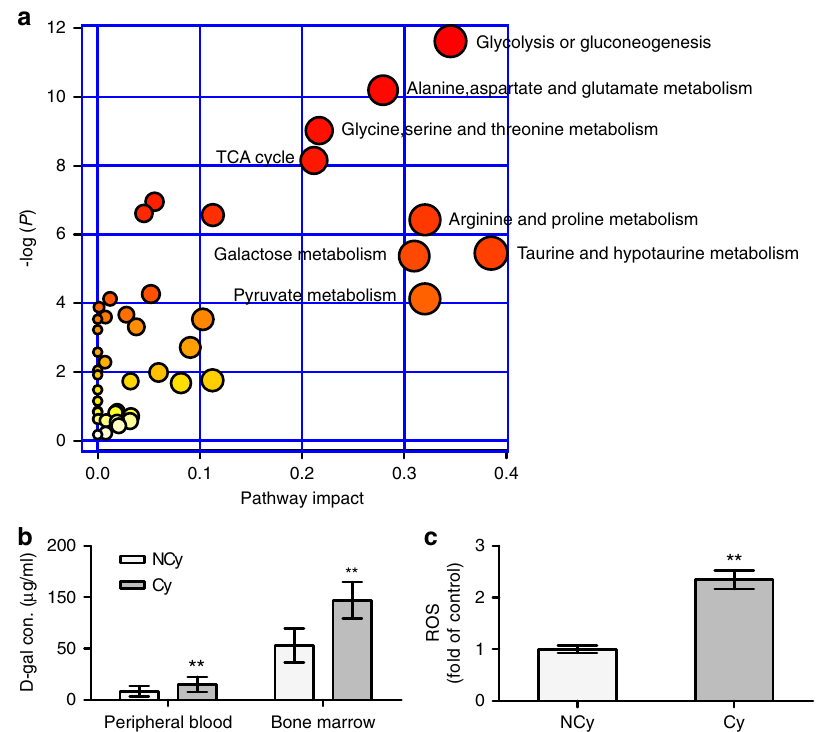
Fig. 2 Profound hypoxia altered metabolic pro fi ling in BM. a Pathway analysis of 49 metabolites identi fi ed as being present in the Cy group but not in the NCy group. x Axis represents the pathway impact, and y axis represents the pathway enrichment. Larger sizes and darker colours represent increased pathway enrichment and higher pathway impact values, respectively. b D -galactose concentrations in the peripheral blood ( n = 22 per group) and bone marrow ( n = 5 per group) of patients were analysed. c ROS levels of BMSCs from the NCy and Cy groups were analysed. The data shown are the mean ± SD from three independent experiments, and statistical signi fi cance was analysed using Student ’ s t -test (** P <